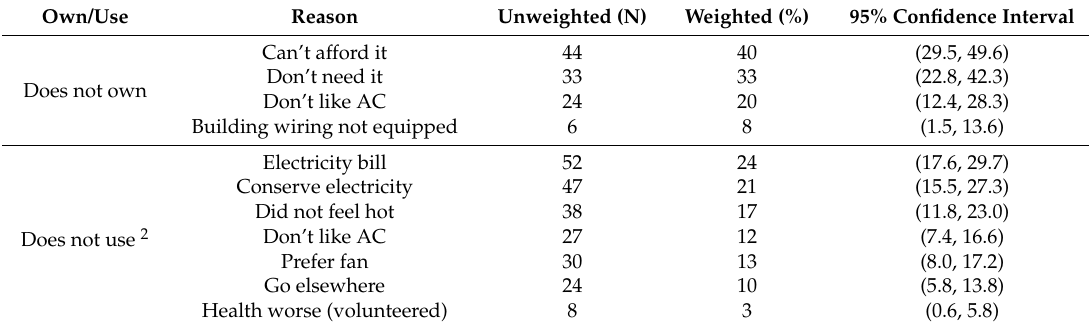
Table 2. Reasons for not owning or not using AC 1 , New York City,